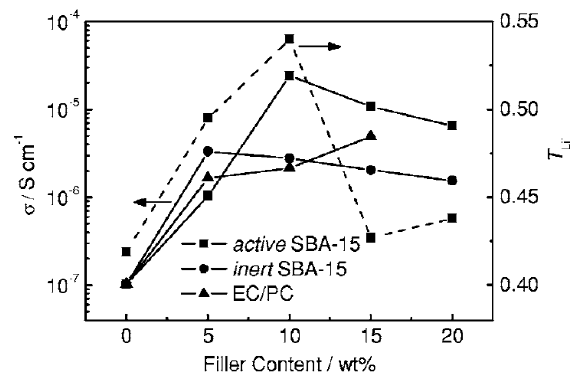
Figure 12. Ionic conductivity σ and lithium transference number t + as a function of active SBA-15 (mesoporous silica) content for PEO (300,000 g/mol)–LiClO 4 –SiO 2 (1000 m 2 ·g − 1 ) CPE at 25 °C. For comparison, the ionic conductivity with inert SBA-15, as well as that with EC/propylene carbonate (PC), is also presented. Reproduced with permission from Wang et al. [64]. Copyright 2007, American Institute of Physics.